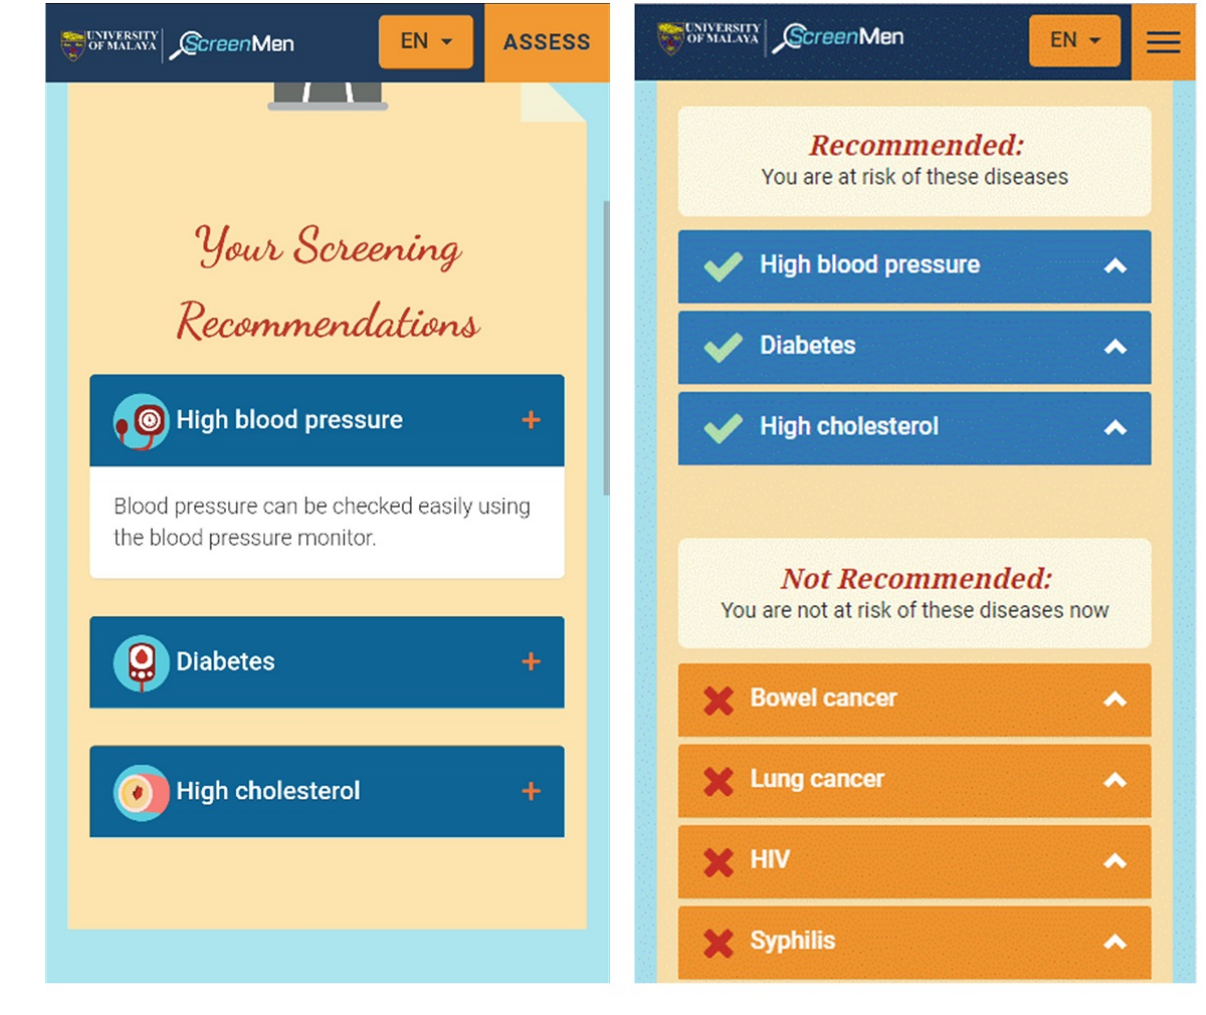
Figure 3. User’s list of screening recommendation without and with emphasis of not recommended